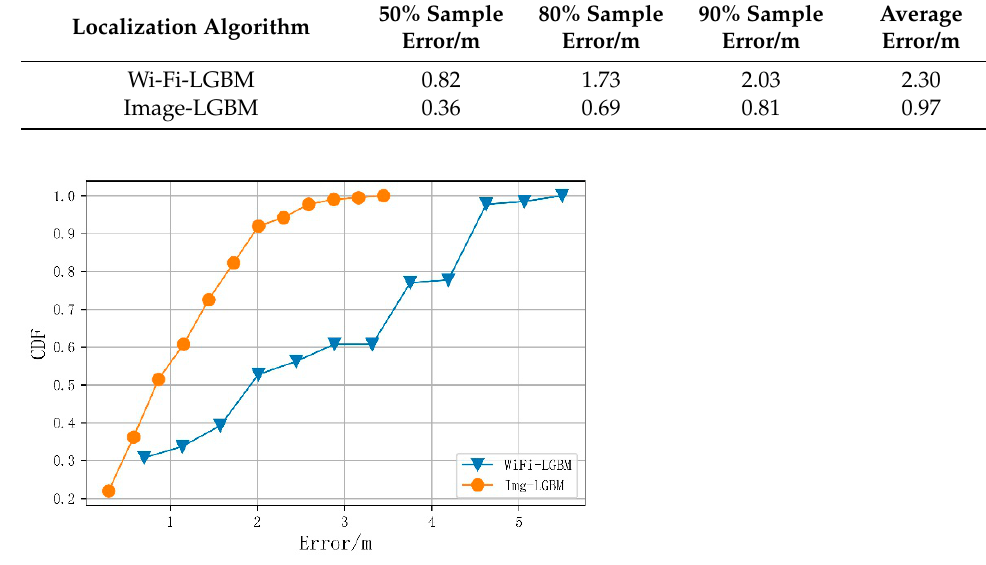
Figure 7. Cumulative probability distribution of positioning error for a single-fingerprint dataset.